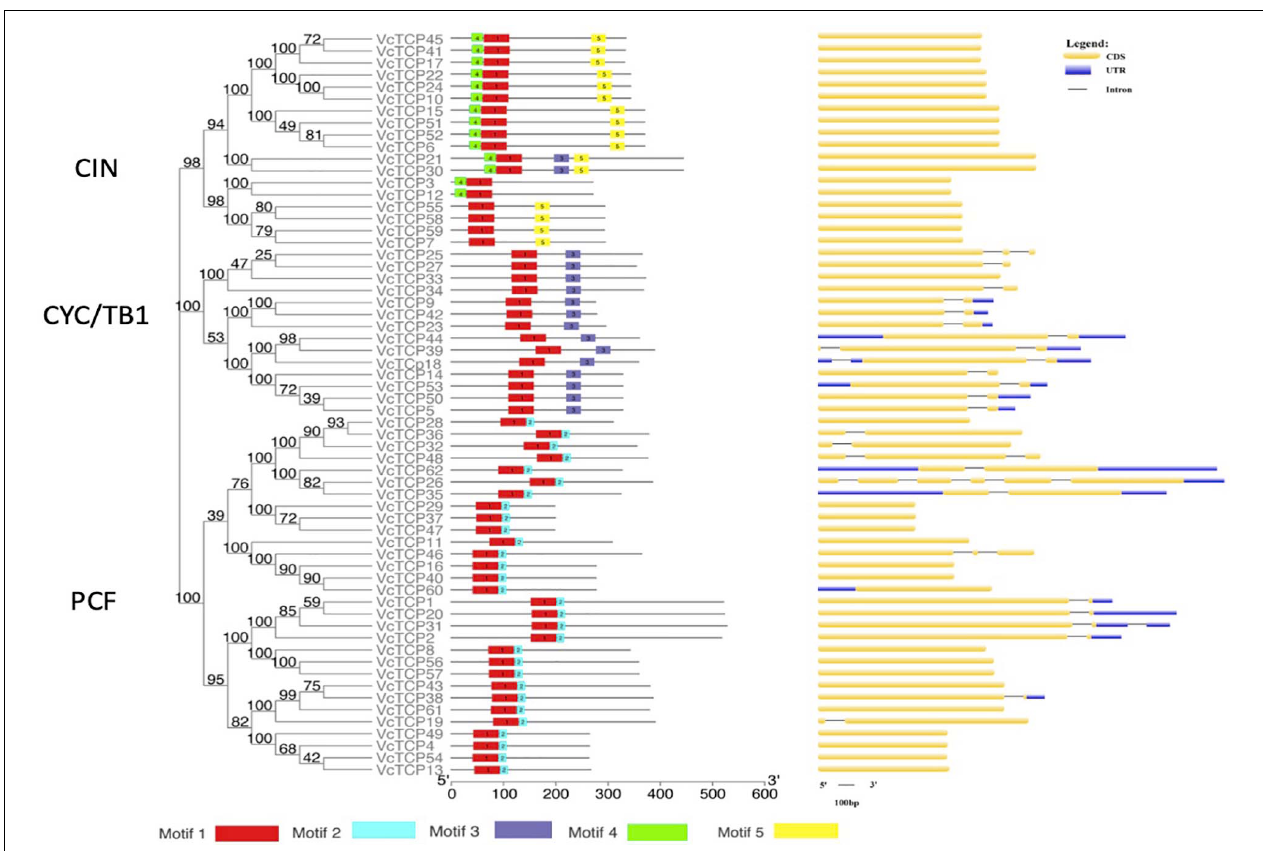
FIGURE 3 | Phylogenetic analysis, conserved motifs and gene structure of the TCP family in blueberry. Conserved motifs of VcTCPs were identified using MEME. Different motifs are shown by different colors. CDS, introns and UTR are indicated by yellow rectangles, black lines and blue rectangles,